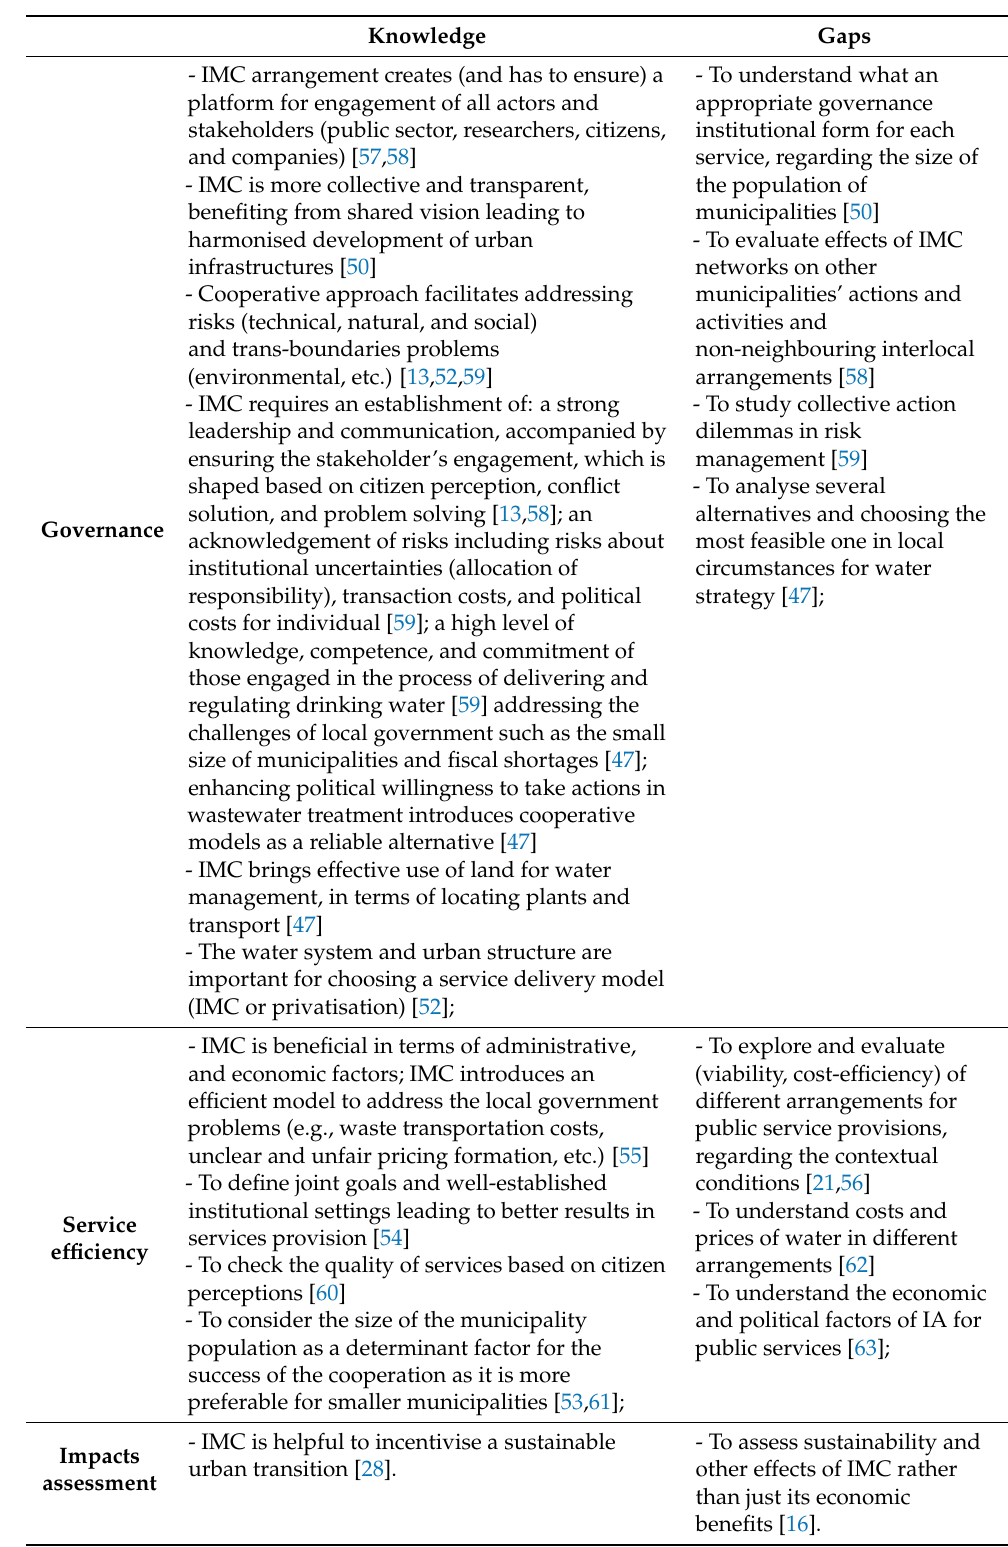
Table 4. Summary of emerging knowledge and gaps in articles crossing IMC and